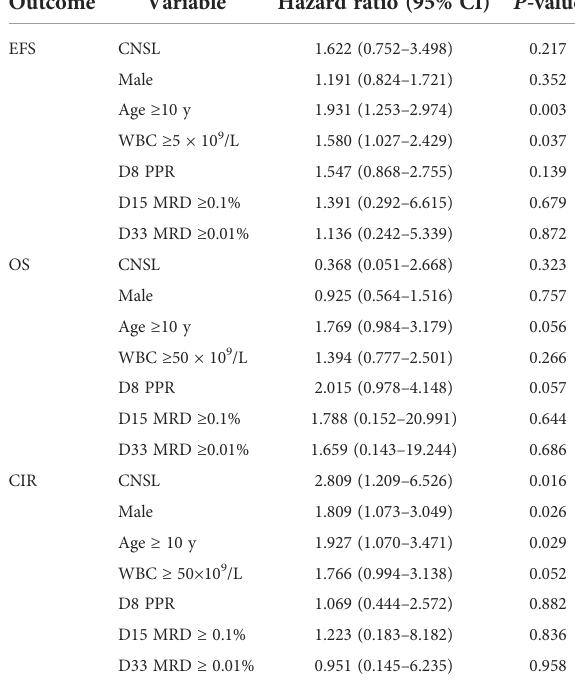
TABLE 3 Multivariate analysis for EFS, OS and CIR in childhood